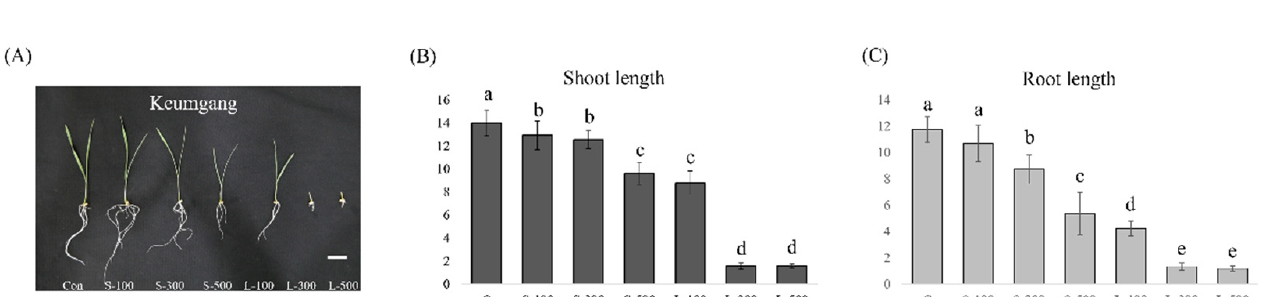
Figure 2. Gamma radiation dose and exposure time effects on seed germination percentage. The seed germination percentages were determined daily for 4 days. DAG, days after germination. Each bar represents the mean ± SD.